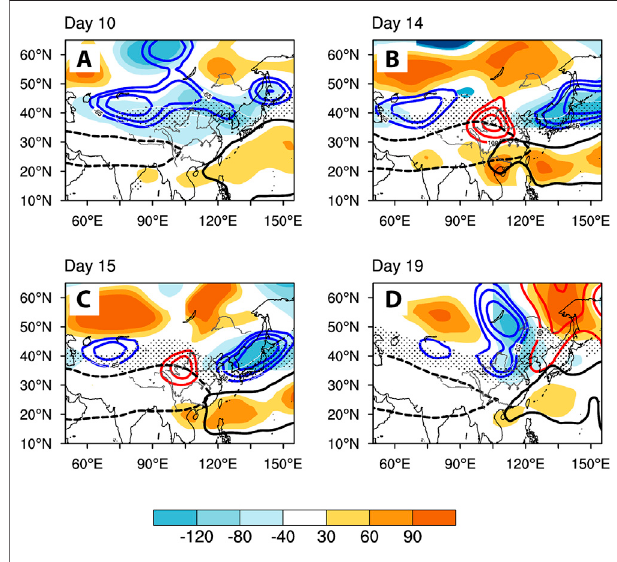
FIGURE 6 | Evolution of the circulation con fi guration at 200 and 500 hPa on (A) July 10, (B) July 14, (C) July 15, and (D) July 19, 2020. The red contour denotes the positive geopotential height anomaly at 200 hPa; the blue denotes the negative; the shaded area denotes the anomaly of 500 hPa geopotential height (unit: gpm); the black dotted line denotes 12,570 gpm contourat200hPa;theblacksolidlinedenotes5,880gpmcontourat500hPa; the point area denotes westerly jet with wind speed ≥ 30 m s − 1 at 200